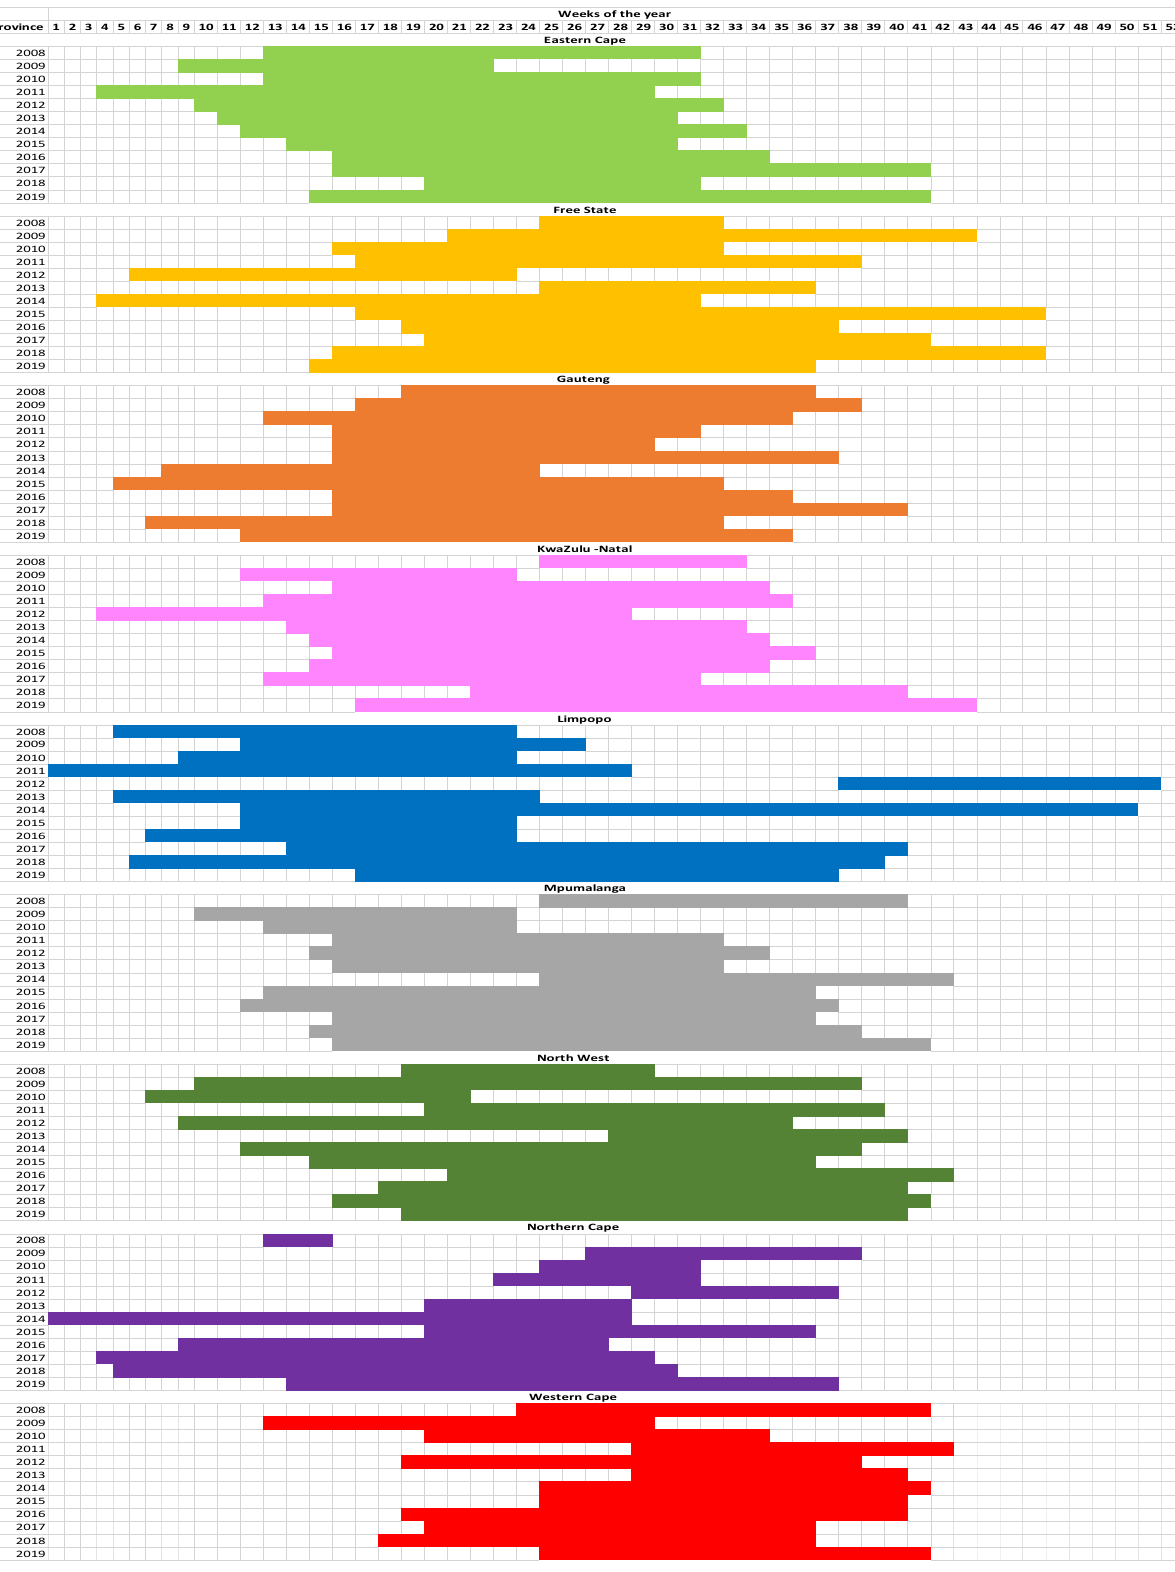
Figure 7. Threshold graphs showing the different thresholds for the nine South African provinces, respectively.